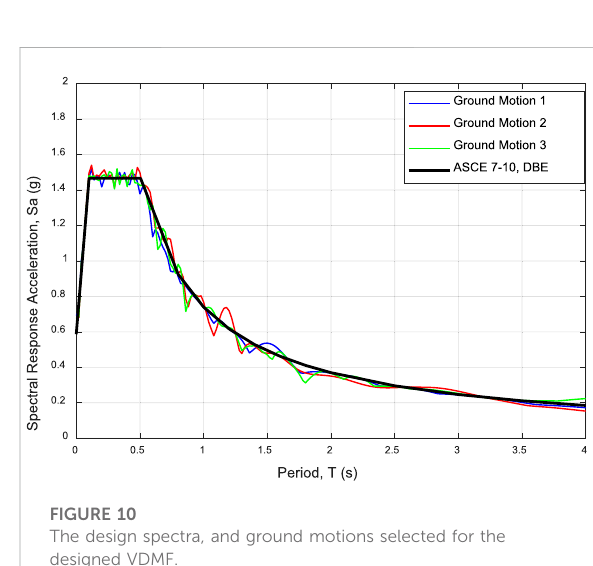
FIGURE 10 The design spectra, and ground motions selected for the designed